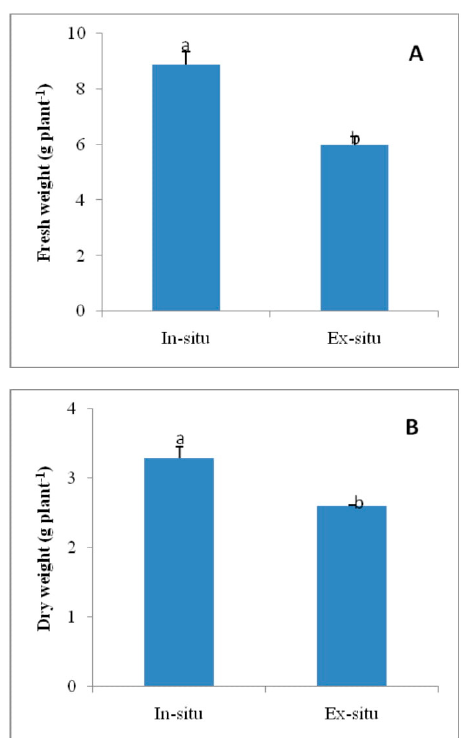
Figure 5. Fresh weight ( A ) and dry weight ( B ) in in-situ and ex-situ grown plants of Valeriana wallichii . Data are presented as treatments mean ± SE ( n = 5). SE = standard error; n = number of samples. The mean difference of in-situ from ex-situ was considered statistically significant at p < 0.05 (using Student’s t -test). Data followed by the same letter are not significantly different.